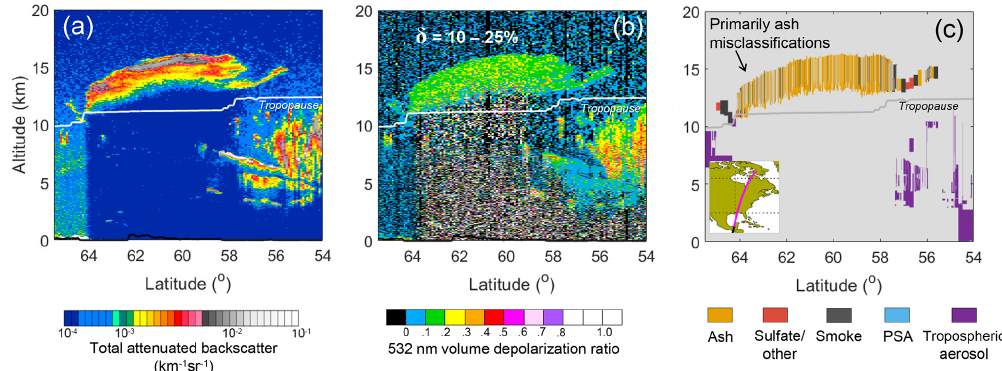
Figure 1. PyroCb smoke plume from the PNW event on 18 August 2017 at ∼ 07:45UTC over Quebec Province, Canada: (a) 532nm total attenuated backscatter, (b) 532nm volume depolarization ratio, and (c) V4.1 aerosol subtype classification from the level 2 vertical feature mask. Inset map shows the CALIOP ground track.